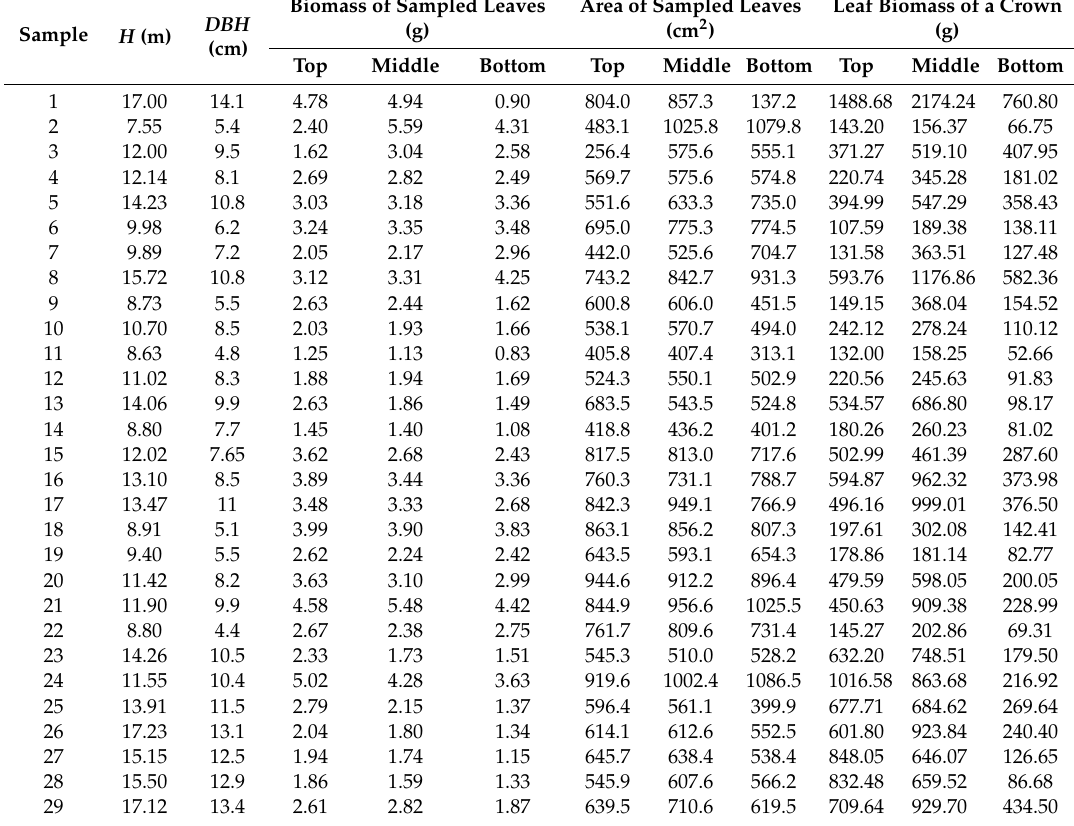
Table 1. Plant characteristics of the 29 Moso bamboo crowns. H is the tree height; and DBH is the diameter at breast